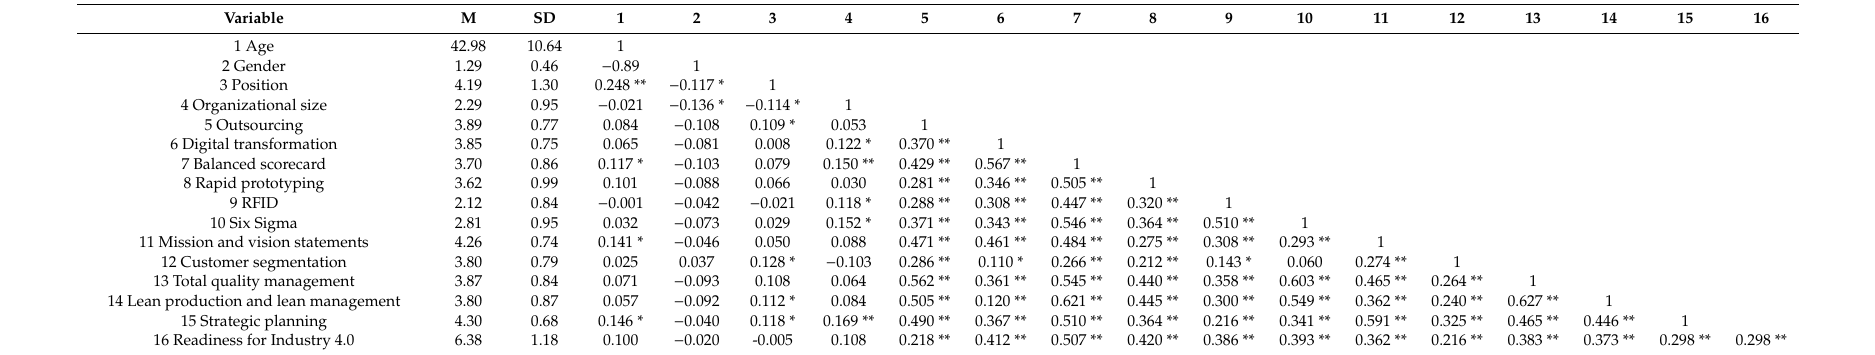
Table 1. The means (M), standard deviations (SD), and correlations among the studied